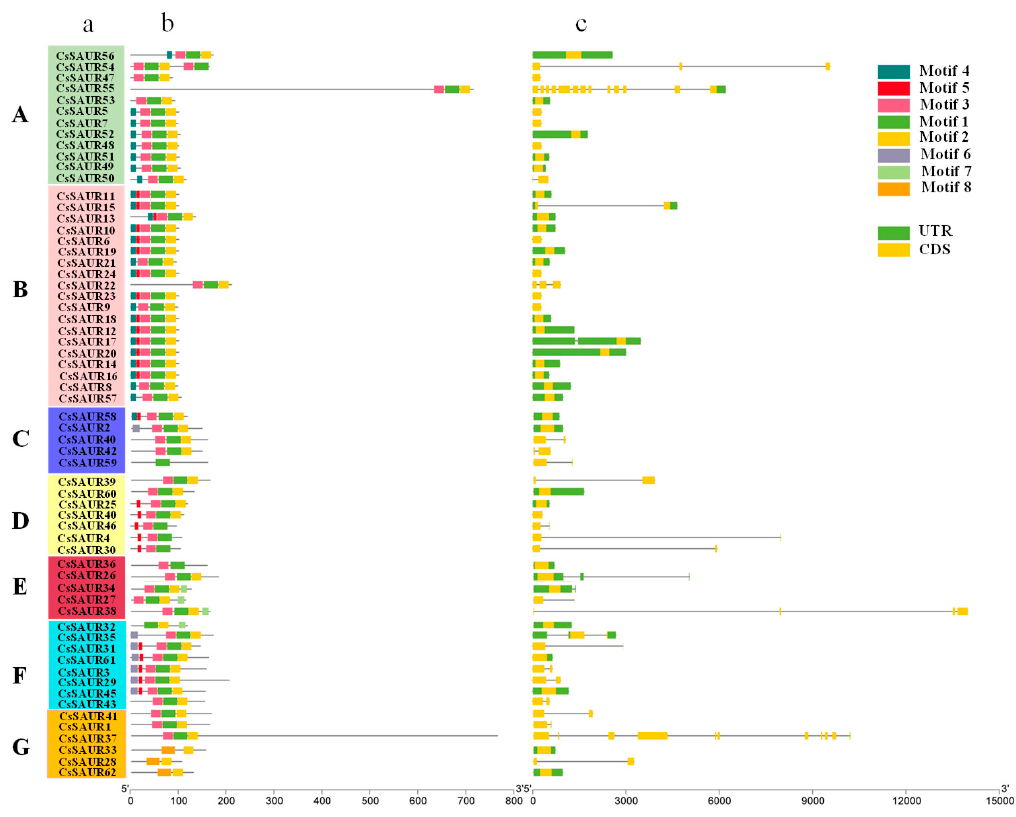
Figure 3. CsSAUR motifs and gene structures. ( a ) Clustering analysis. ( b ) Motif architecture. ( c ) CDS and UTR. The background colors and the le tt ers highlight di ff erent cluster branches.